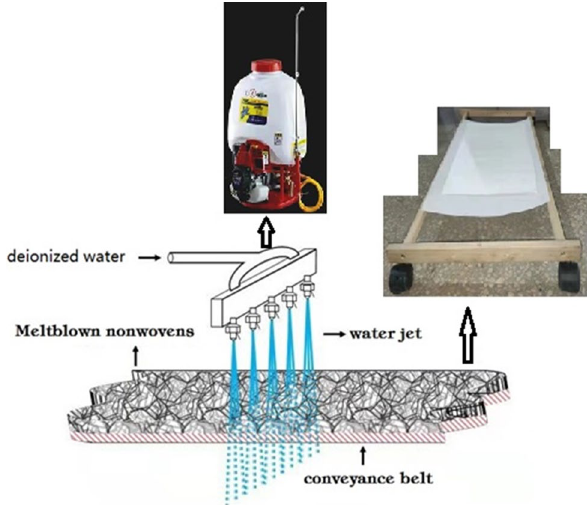
Figure 1. The schematic diagram of triboelectric charging process.